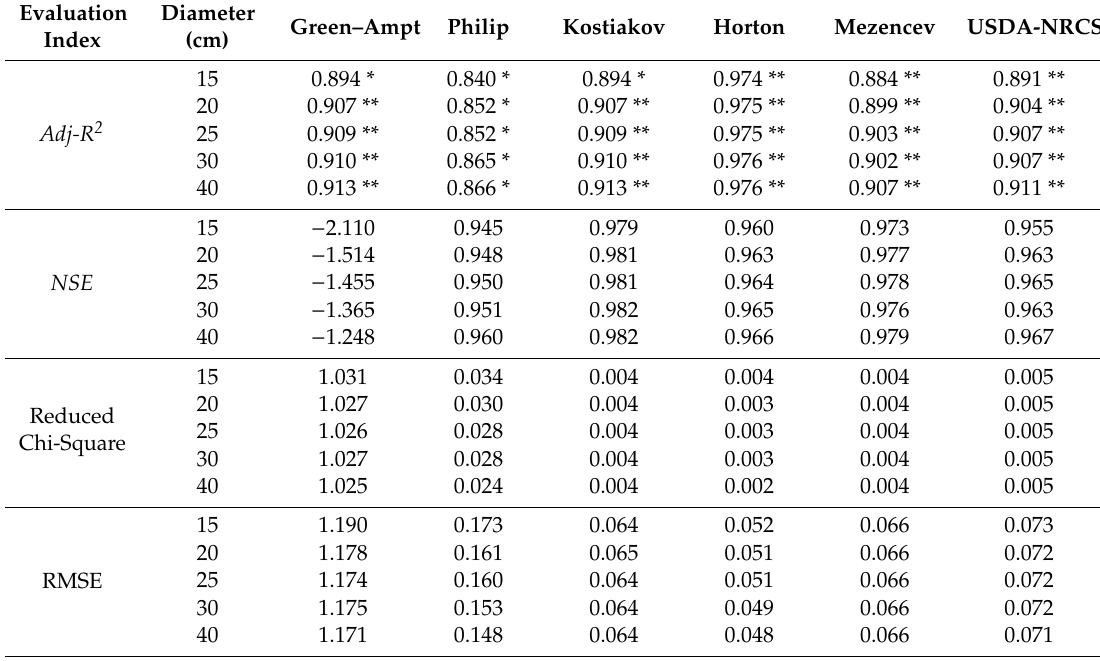
Table 3. Four evaluation index values of the six evaluated soil infiltration models for five di ff erent inner-diameter